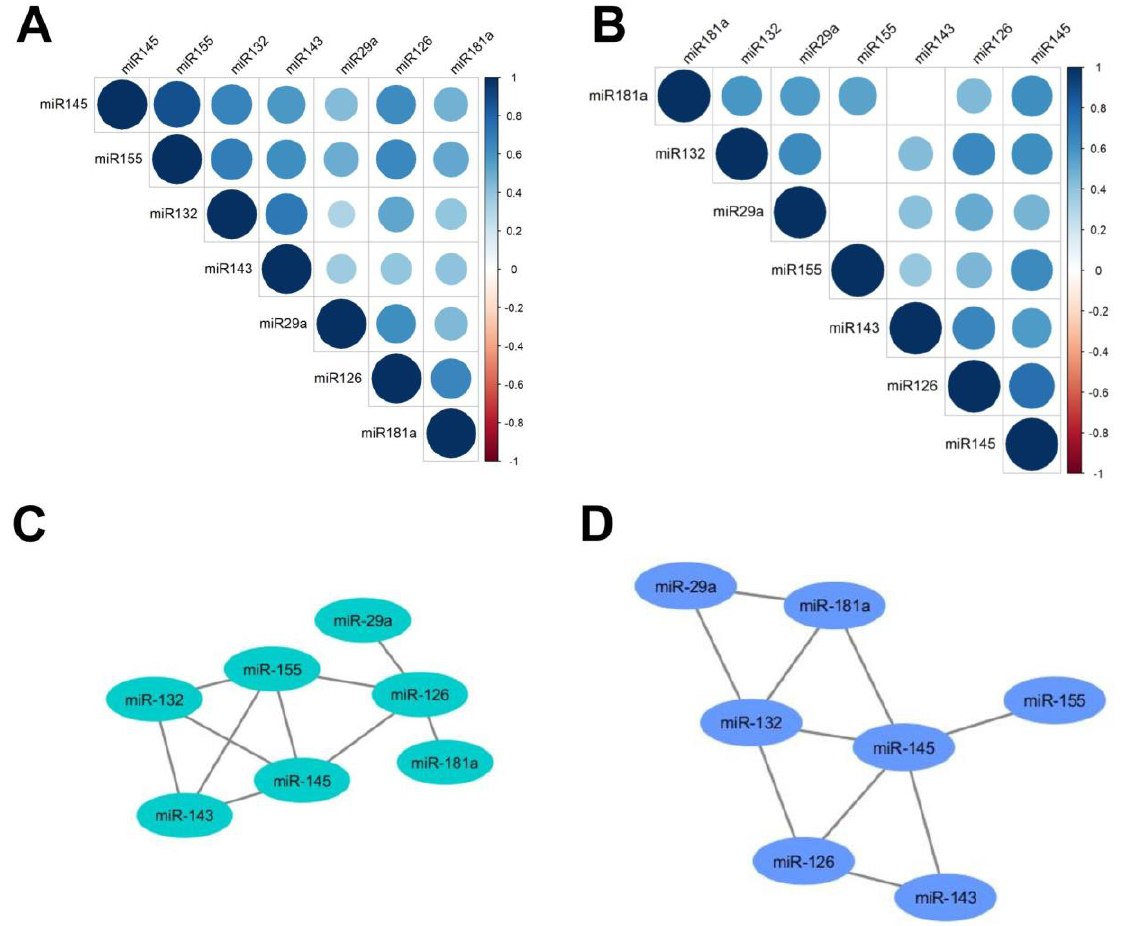
Figure 2. Correlation heatmap of analyzed microRNA levels in serum in ( A ) healthy subjects and ( B ) patients with systemic sclerosis. Only statistically significant correlations are shown with a circle. Below, network of high, statistically significant correlations ( r ≥ 0 .6) between analyzed microRNA levels in serum in ( C ) healthy subjects and ( D ) patients with systemic sclerosis. Spearman correlation test.